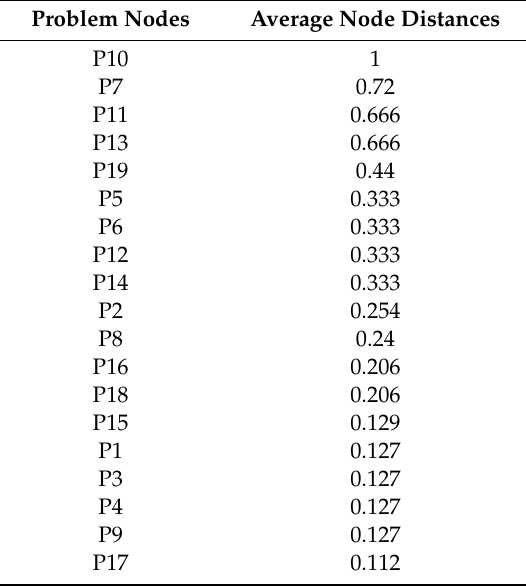
Table 8. The average node distances.